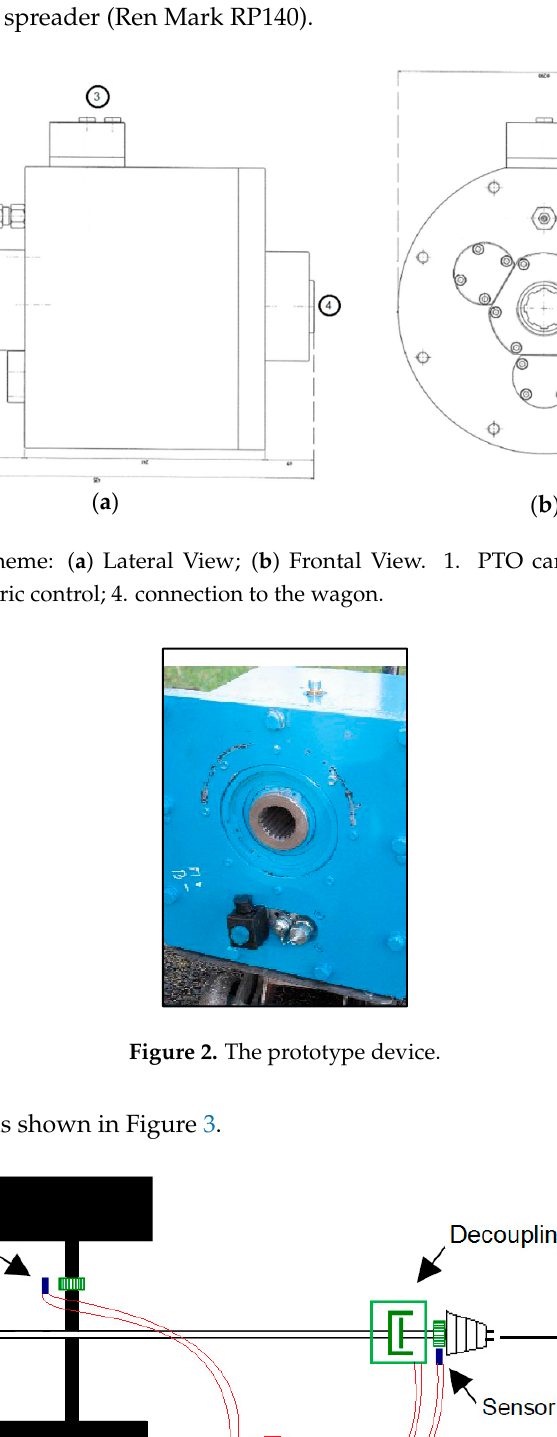
Figure 4. Sensor mounted on the wheel. Figure 5. Microprocessor and beeper. When the sensor no longer detects the metal surface on the drum for a time less than or equal to 6 seconds, the system activates the blinking and deactivates the output to release the movement of the mechanical organs by stopping its movement as a function of the motion detection by the sensor